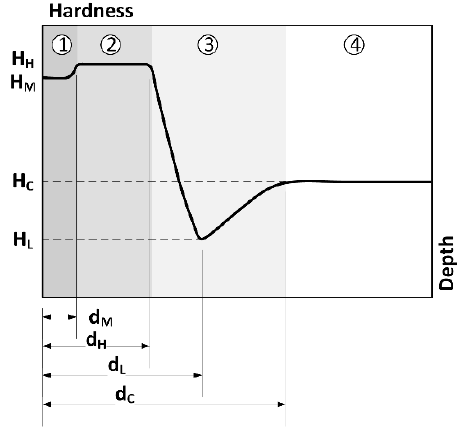
Figure 2. Representation of LHQ elements through the hardness profile curve.